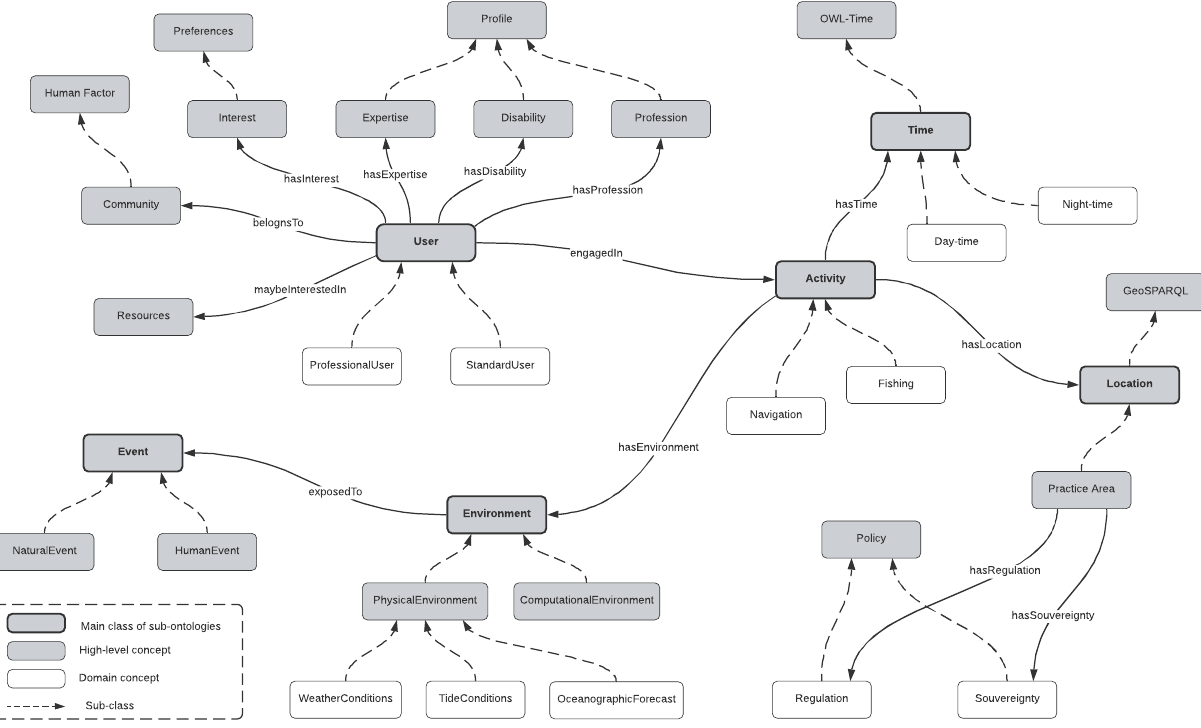
Figure 4. Partial taxonomy overview of concepts related to the sub-ontologies: event, user, activity, location, time, and